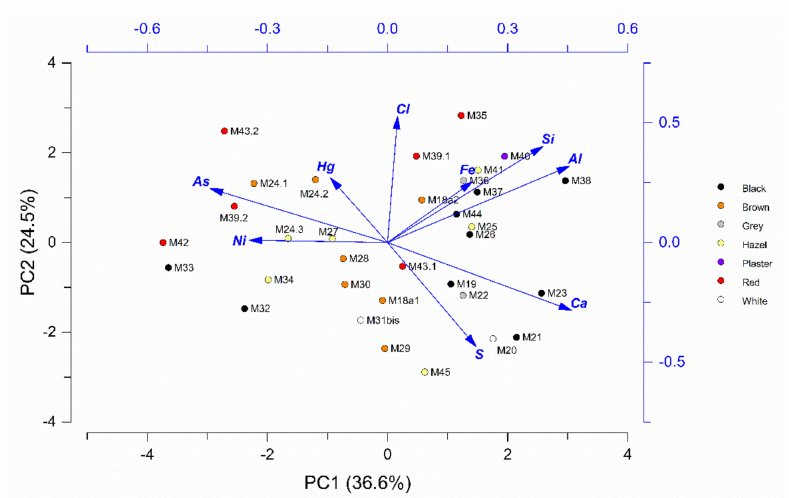
Figure 2. PCA biplot on the net area under the X-ray characteristic peaks of the main elements composing the paint